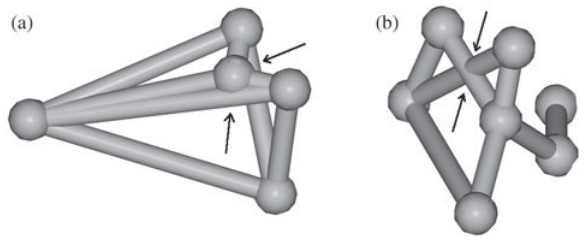
Figure 6. Simulated porous structures, for the same material, with Dim of 100 nm, 200 nm, 250 nm and 300 nm.